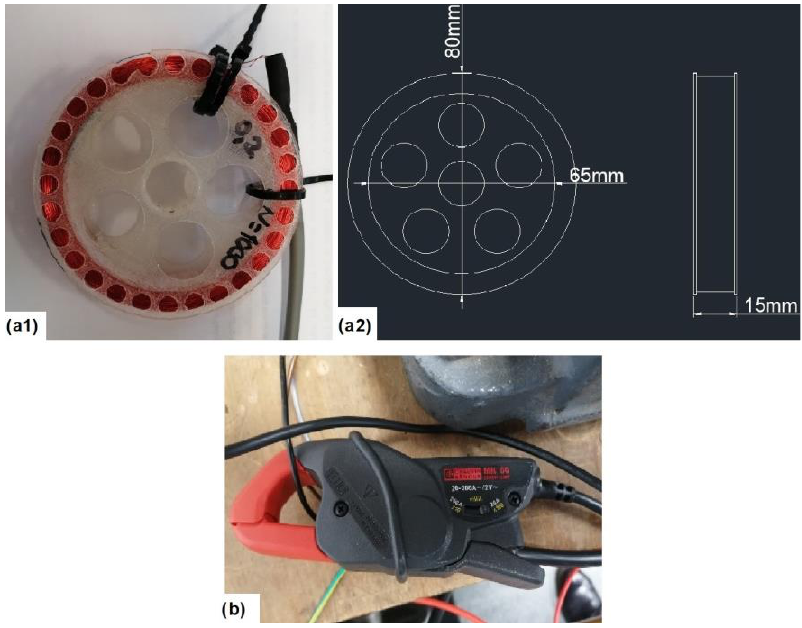
Figure 10. Sensors employed: ( a1 ) Handmade coil-flux sensor. ( a2 ) Dimensions and shape of the coil sensor. ( b ) Current clamp.